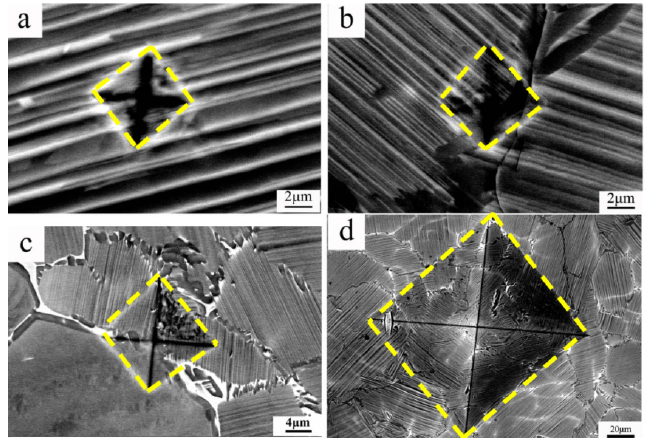
Figure 5. The impression left by microhardness indenter ( a – c ) and Vickers hardness indenter ( d ) in S1: ( a ) within lamellar colony; ( b ) on the colony boundary; ( c , d ) on both lamellar colony and β o and γ phases.